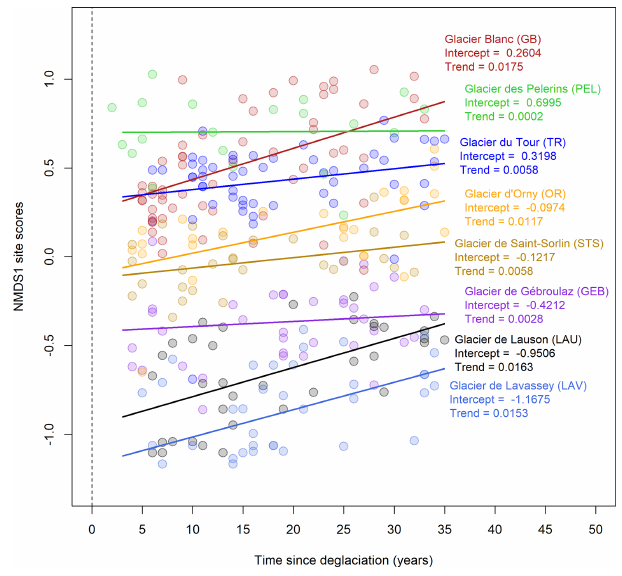
Figure 9. First axis scores of the NMDS according to time since deglaciation for the eight glacier forefields. Intercept and slope pa- rameters are based on linear models for each glacier